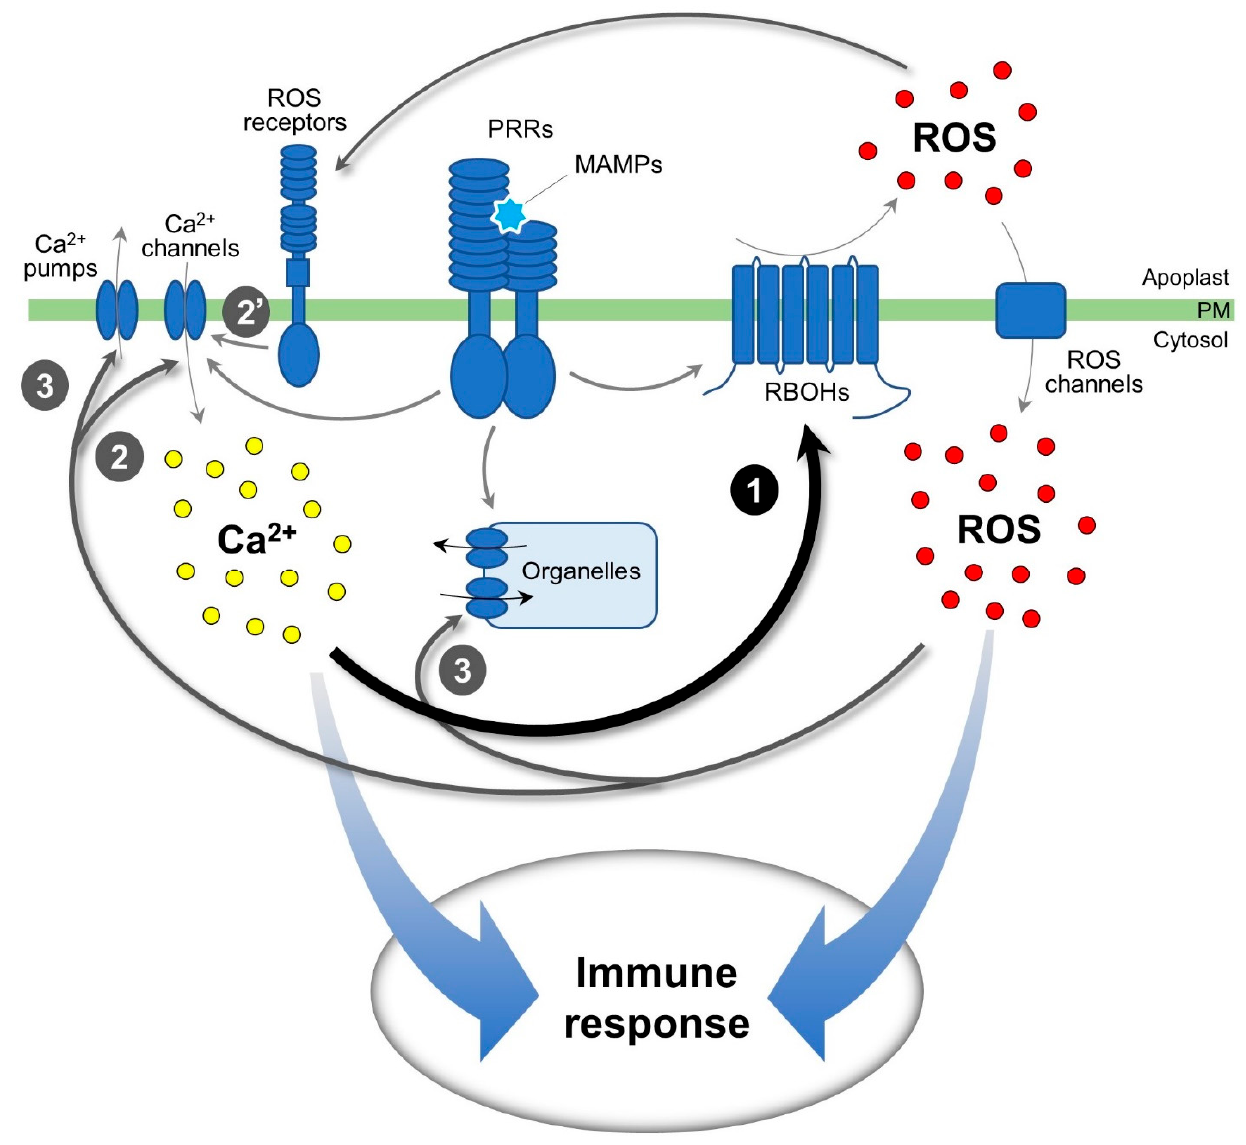
Figure 5. Mutual interplay of calcium and ROS signaling in plant immune response. The MAMP-induced calcium signal has a significant impact on the initiation and amplification of the apoplastic ROS signal, where RBOHs are a central hub for the calcium-dependent ROS signaling (1). In contrast, The MAMP-induced ROS signal has a partial effect on calcium signal but is required for substantial calcium signaling, where a proper formation of calcium signature relies on intracel- lular ROS-dependent regulation of calcium channels (2) and extracellular ROS-dependent regulation of calcium channels via ROS receptors (2 ′ ). In addition, ROS is likely involved in the recovery of cytosolic calcium concentration via regulating calcium pumps (3). The calcium and ROS signals orchestrate together at the proper time and amplitude of pattern-trig- gered immune response.